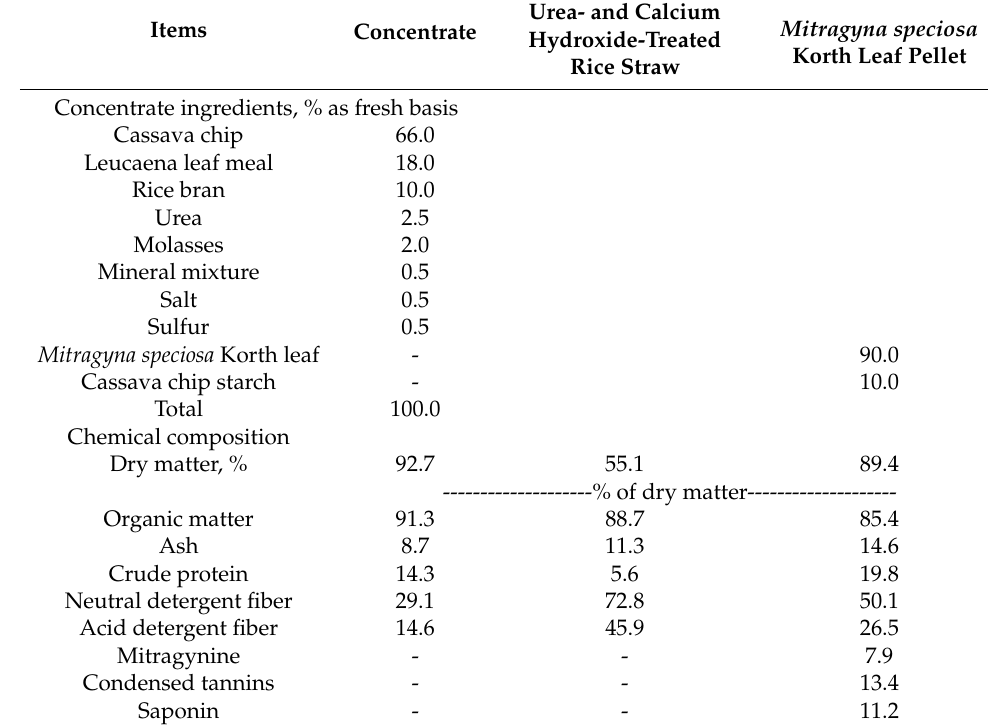
Table 1. Compositions of concentrate mixtures, urea- and calcium hydroxide-treated rice straw, and Mitragyna speciosa Korth leaf pellet. Items Concentrate